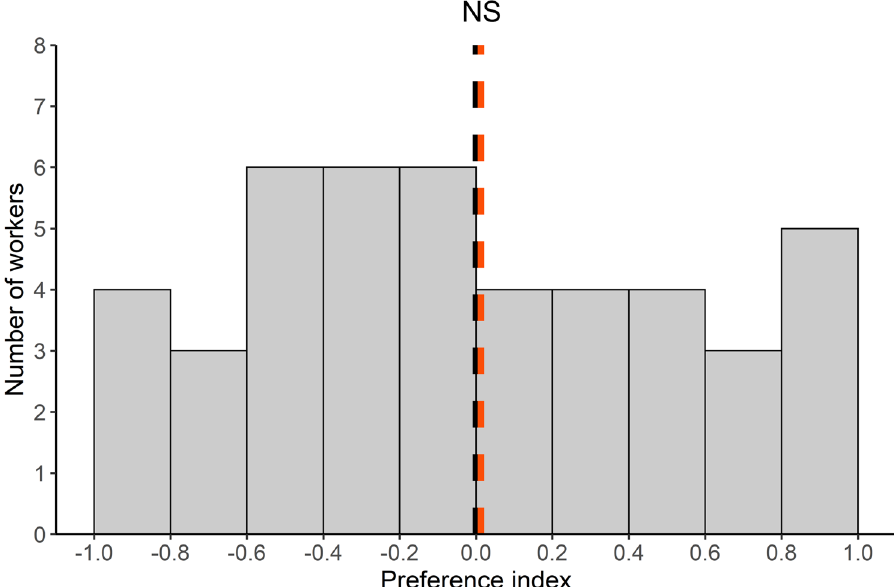
Figure 2. Individual experiment: distribution of the individual preference indices of foragers (n = 45). The dotted orange line represents the average of the individual preference indices and the dotted black line represented the value of 0 expected if contamination has no impact on foragers’ preference. Student’s t-test; NS: non-significant.